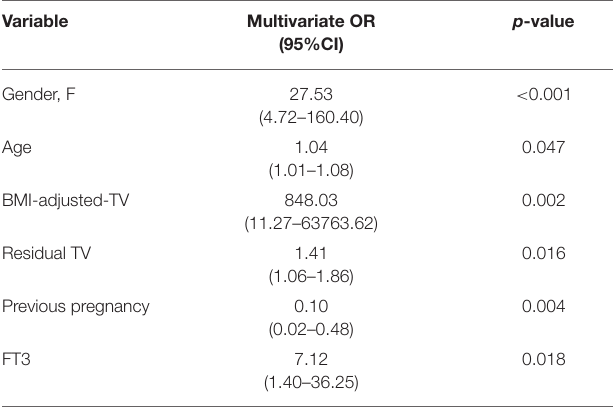
TABLE 4 | Multivariate logistic regression model comparing subjects with and without thyroid